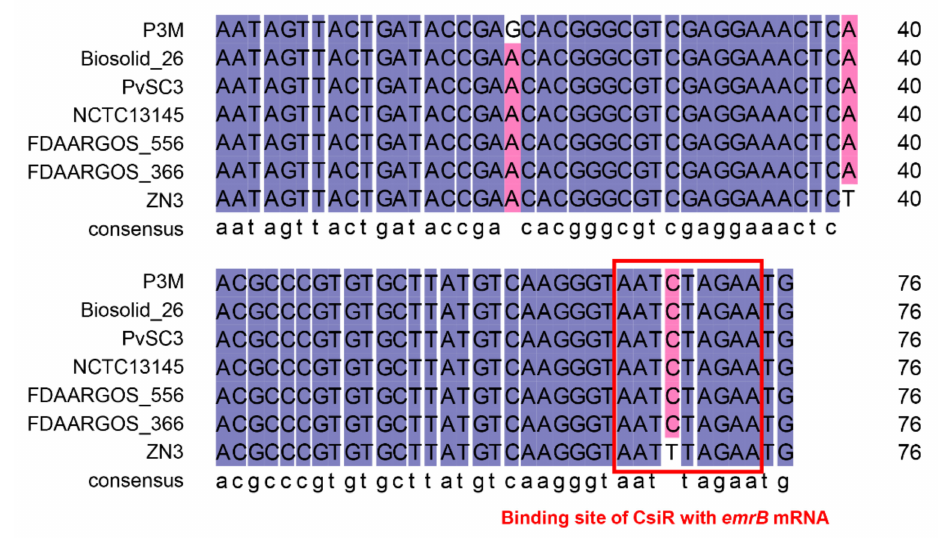
Figure 10. Sequence alignment of csiR in P3M with homologous sequences in all sequenced P. vulgaris strains. Sequences marked with red boxes are the binding sites of CsiR interacting with emrB